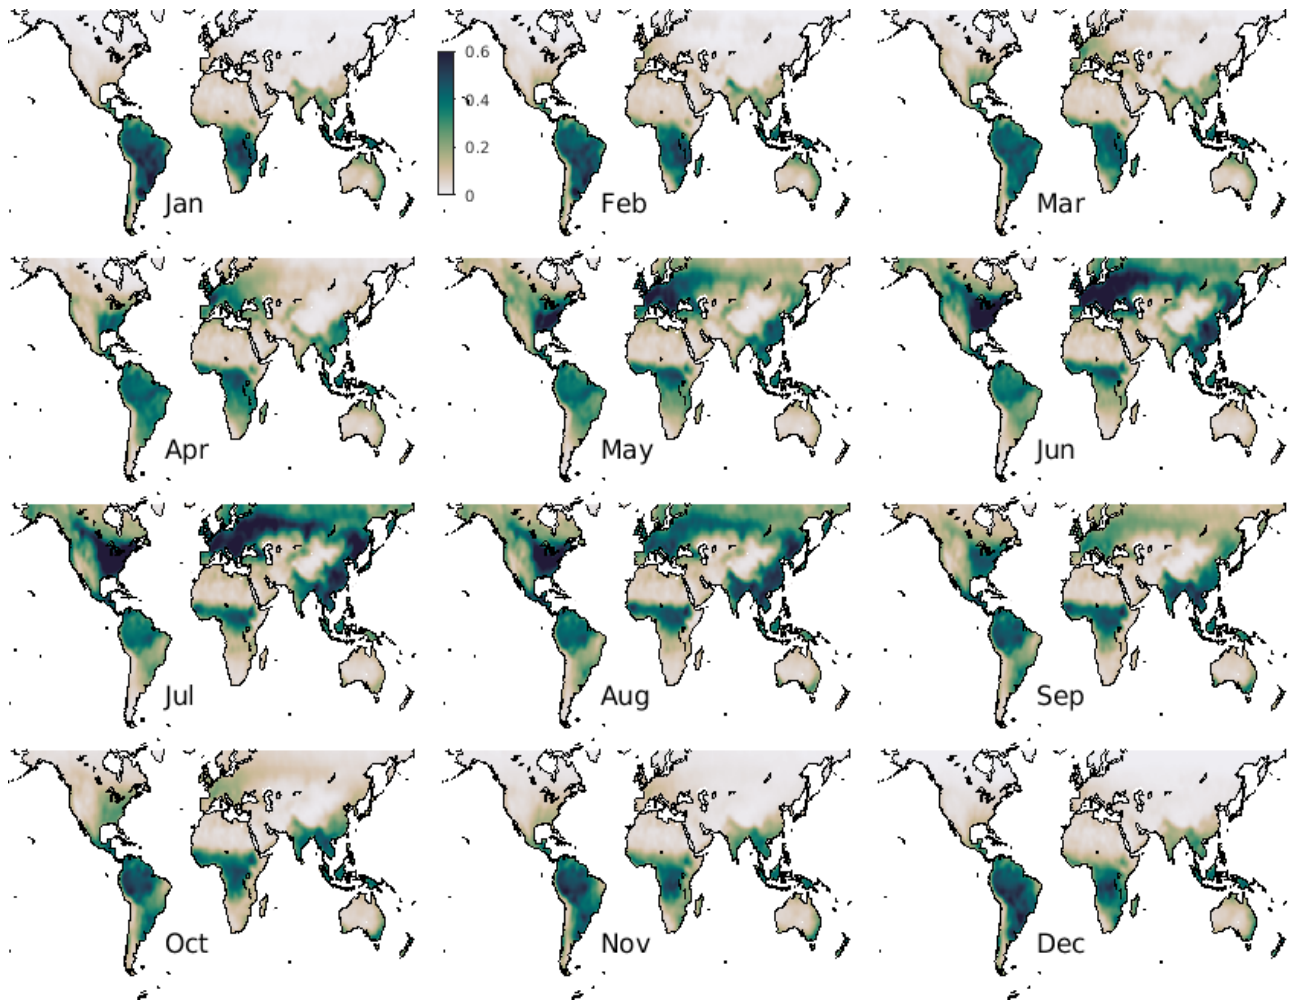
Figure 1. Global long-term (2007–2019) monthly mean solar-induced fluorescence (unit: mW m − 2 sr − 1 nm − 1 ).